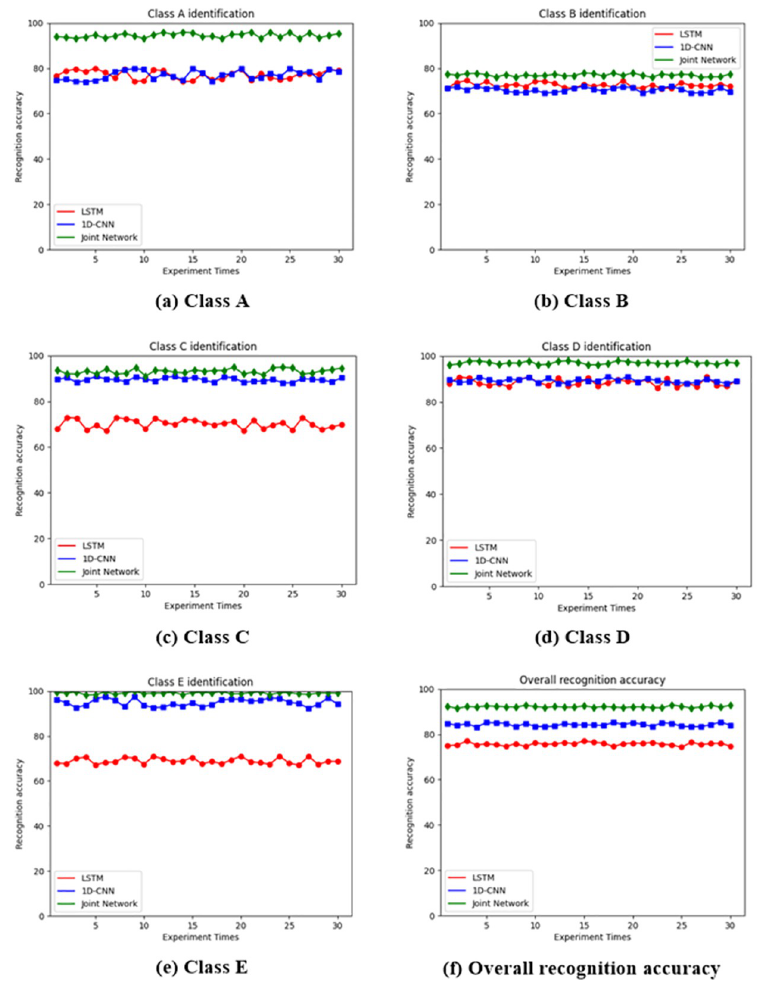
Fig 12. Comparison results of the recognition accuracy of the three networks. (a) Class A; (b) Class B; (c) Class C; (d) Class D; (e) Class E; (f) Overall recognition